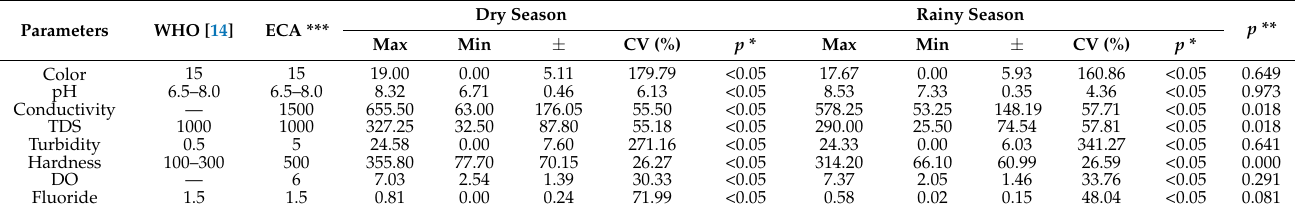
Table 4. Values of water quality parameters for human